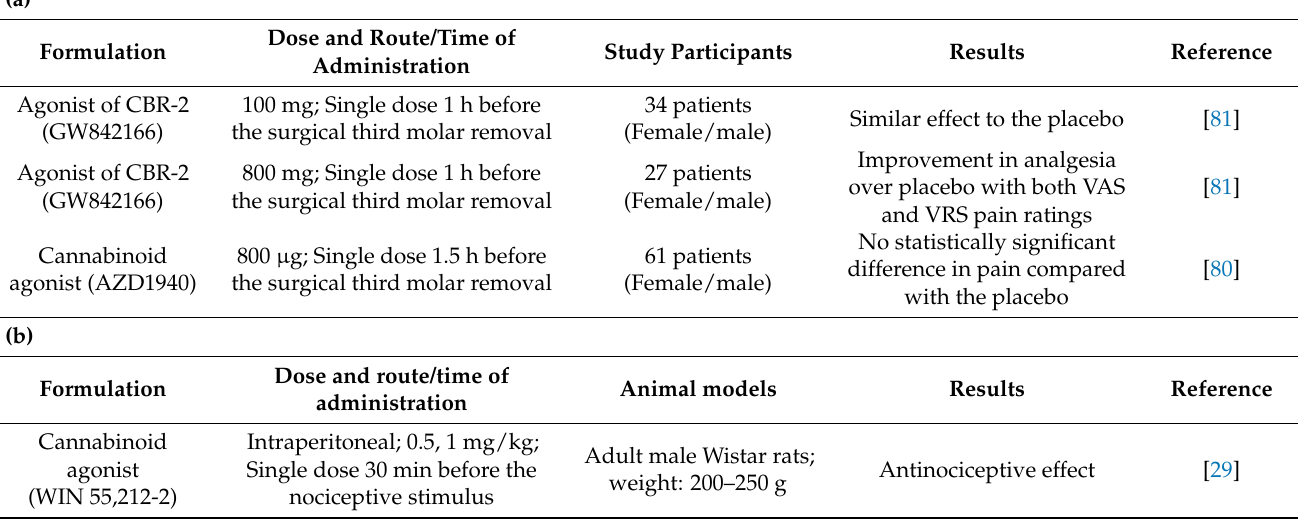
Table 2. An overview of the included studies’ characteristics using synthetic cannabinoid agonist receptors: in panel ( a ) the studies conducted on humans and ( b ) those on animal models are